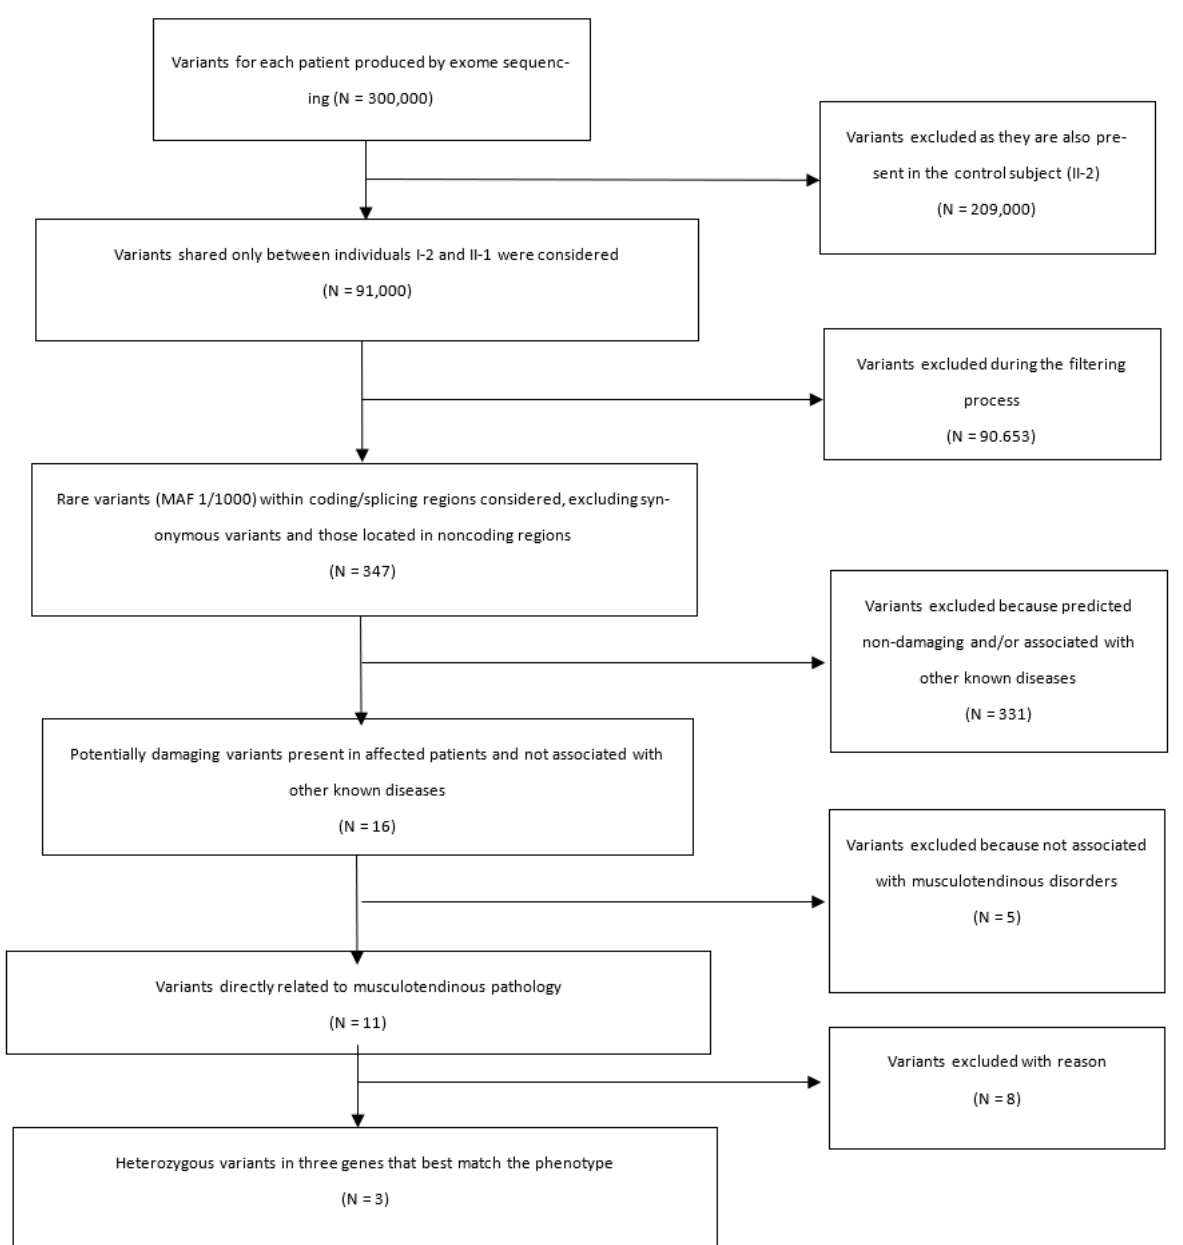
Figure 2. Flow-charts of the process of filtering and prioritization of variants obtained from